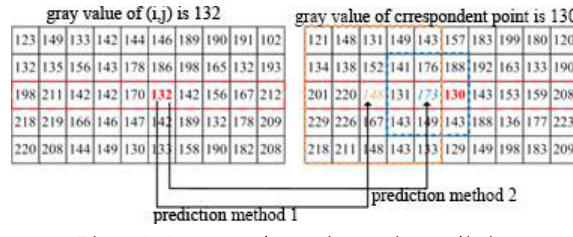
Figure 3. Correspondent point precise